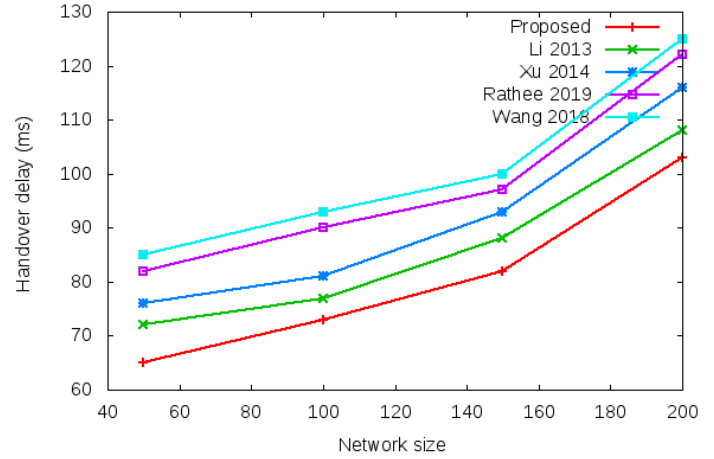
Figure 10. Handover delay of proposed protocol versus existing protocols with a different network size of 50, 100, 150, and 200 nodes based on total computational cost and total communication cost during the handover authentication process.